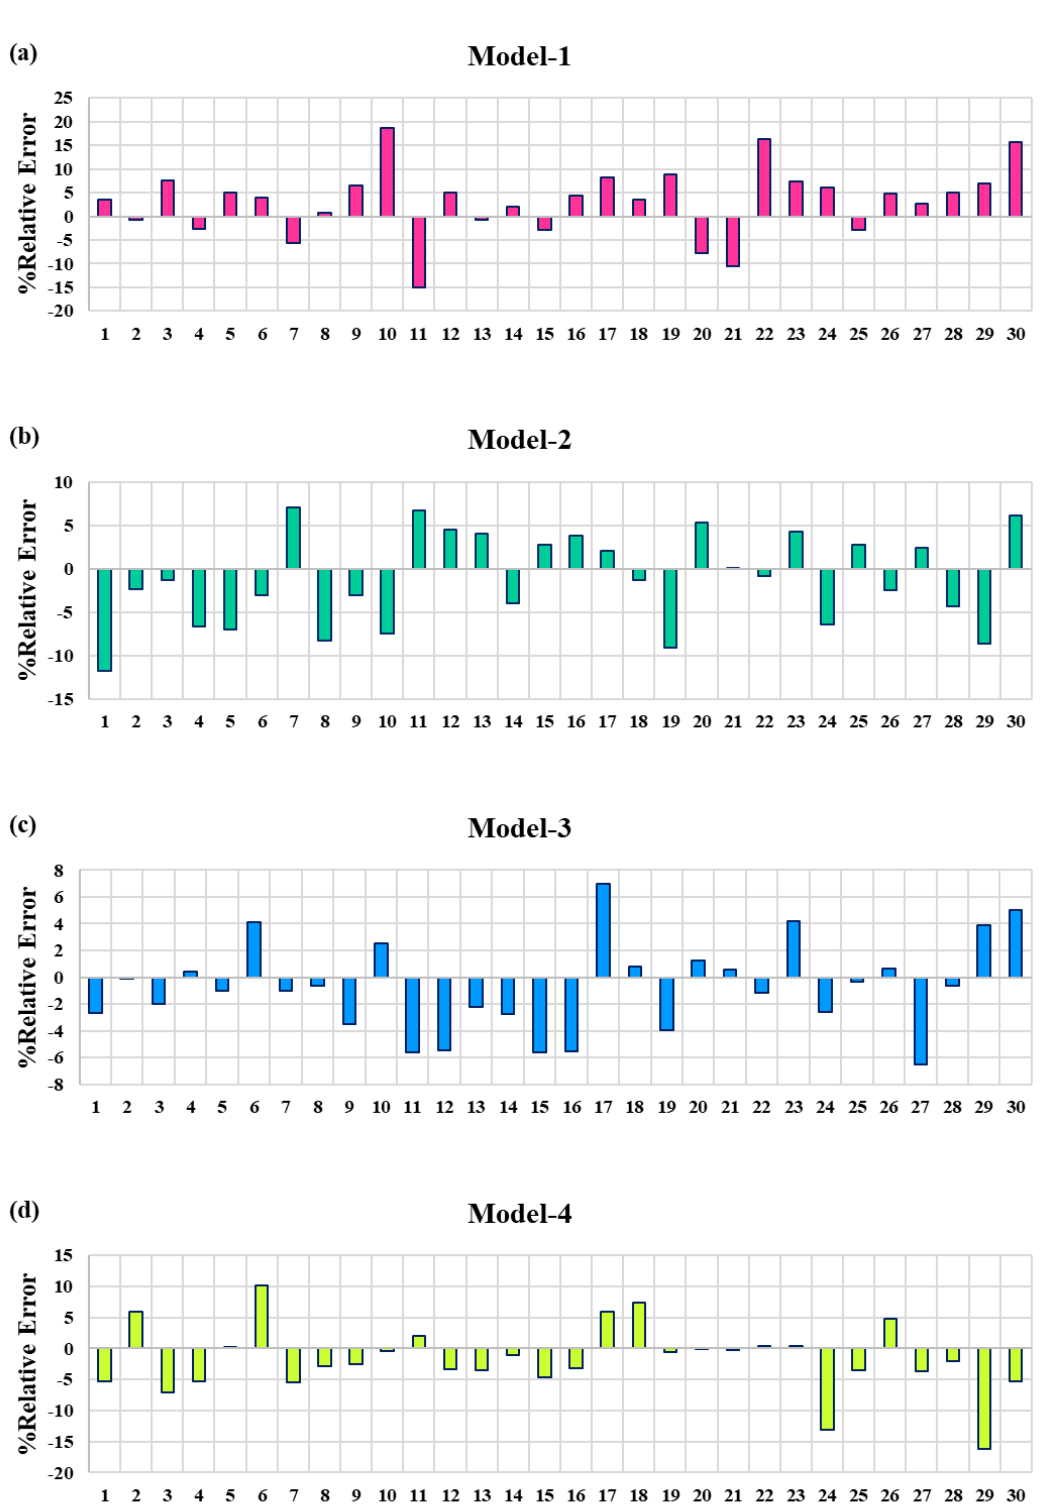
Figure 10. Distribution of the relative error through examination interval for all models using PNN method.